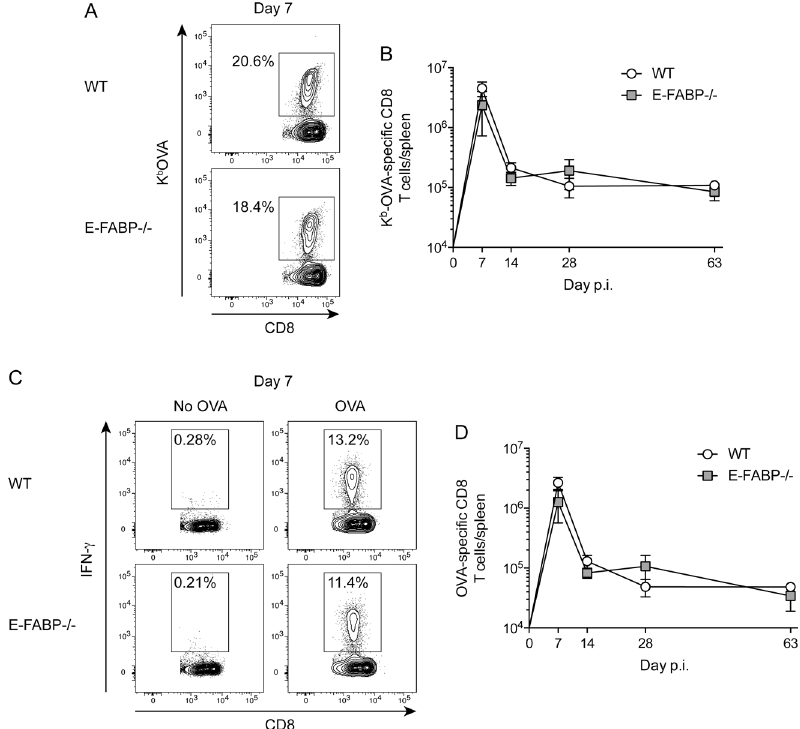
Fig 1. Kinetics of Listeria -specific CD8 T cells in WT and E-FABP-deficient mice. WT and E-FABP-/- mice were infected with 5x10 6 Lm-OVA. OVA-specific CD8 T cells were detected by MHC class I tetramer (K b -OVA 257-264 ) staining (A-B) or peptide (OVA 257-264 ) stimulated intracellular cytokine staining for IFN- γ (C-D). (A and C) Representative contour plots showing the frequency of OVA-specific CD8 T cells, amongst all CD8+ cells, at the indicated days following infection with Lm-OVA. (B and D) Total number of OVA-specific CD8 T cells in the spleen. Data (mean ± s.d.) are from 3-mice/time point/group except day 63 E-FABP-/- (n = 2). Data are representative of two independent experiments and were analyzed by the Mann-Whitney